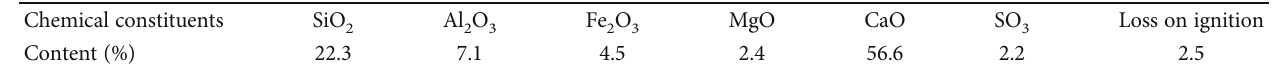
Table 2: The chemical constituents of the Portland cement used in this